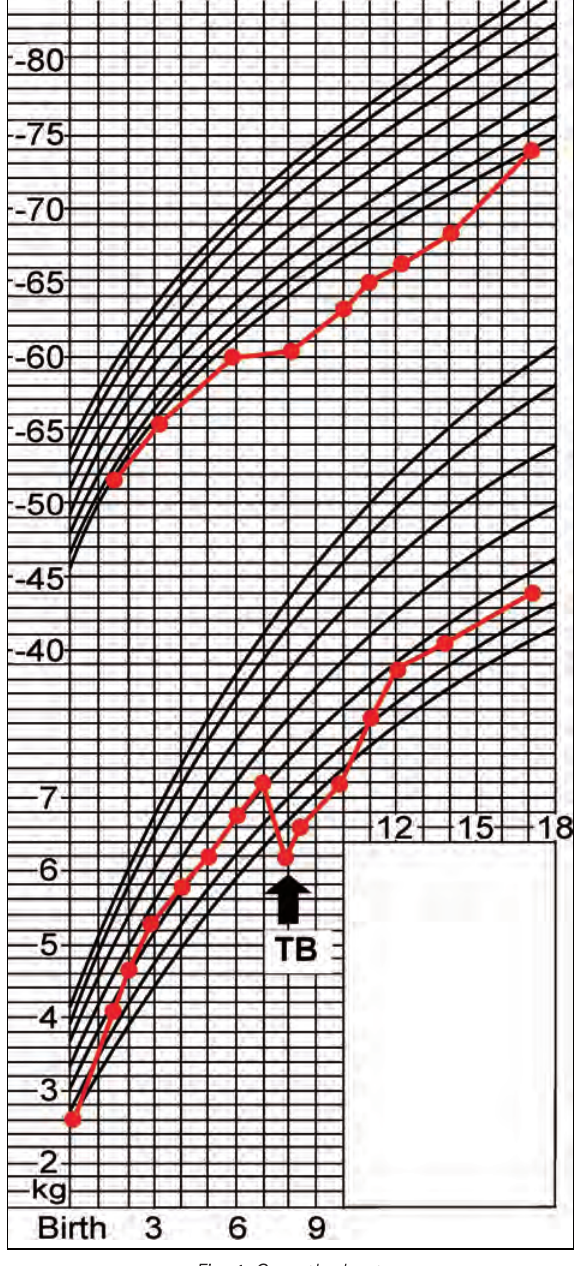
Fig. 1. Growth chart.